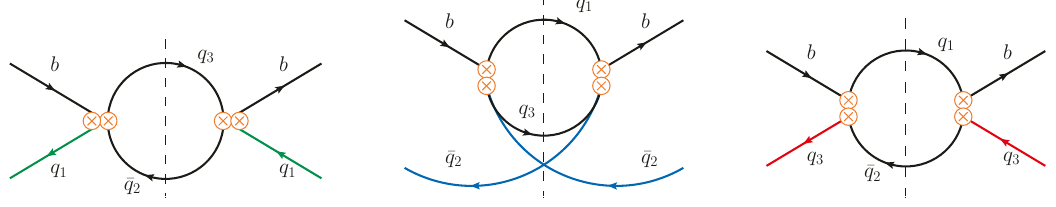
Figure 4 . One-loop diagrams corresponding, from left to right, to the WA, PI and WE topology.